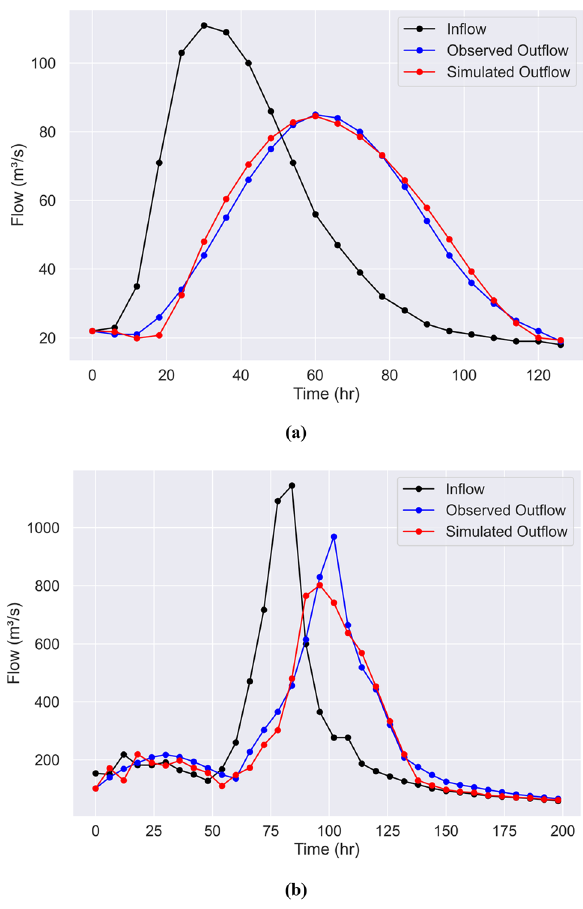
Figure 4. Inflow, observed, and average simulated outflow hydrographs in ( a ) Wilson, and ( b ) Wye River benchmarks.